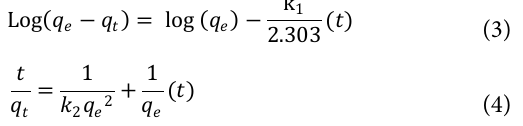
Fig. 8: Effect of Cu Concentration (initial dosage of GO 0.2 mg ml –1 , initial solution pH 5.0).